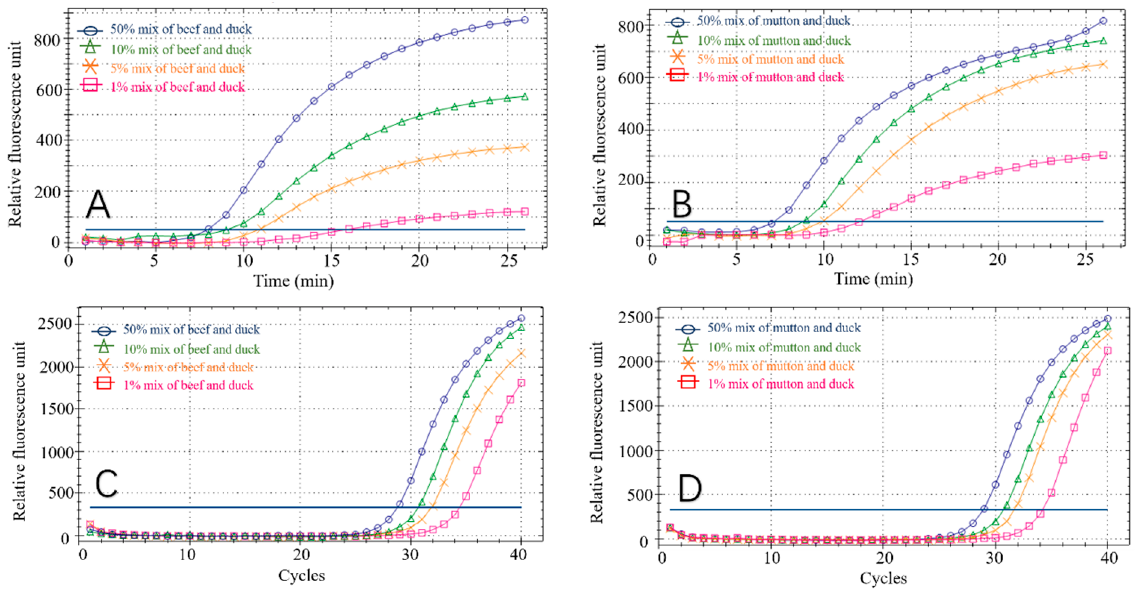
Figure 8. RPA detection results in mixed adulteration ratio for beef–duck ( A ), mutton–duck ( B ), beef–duck ( C ) and mutton–duck ( D